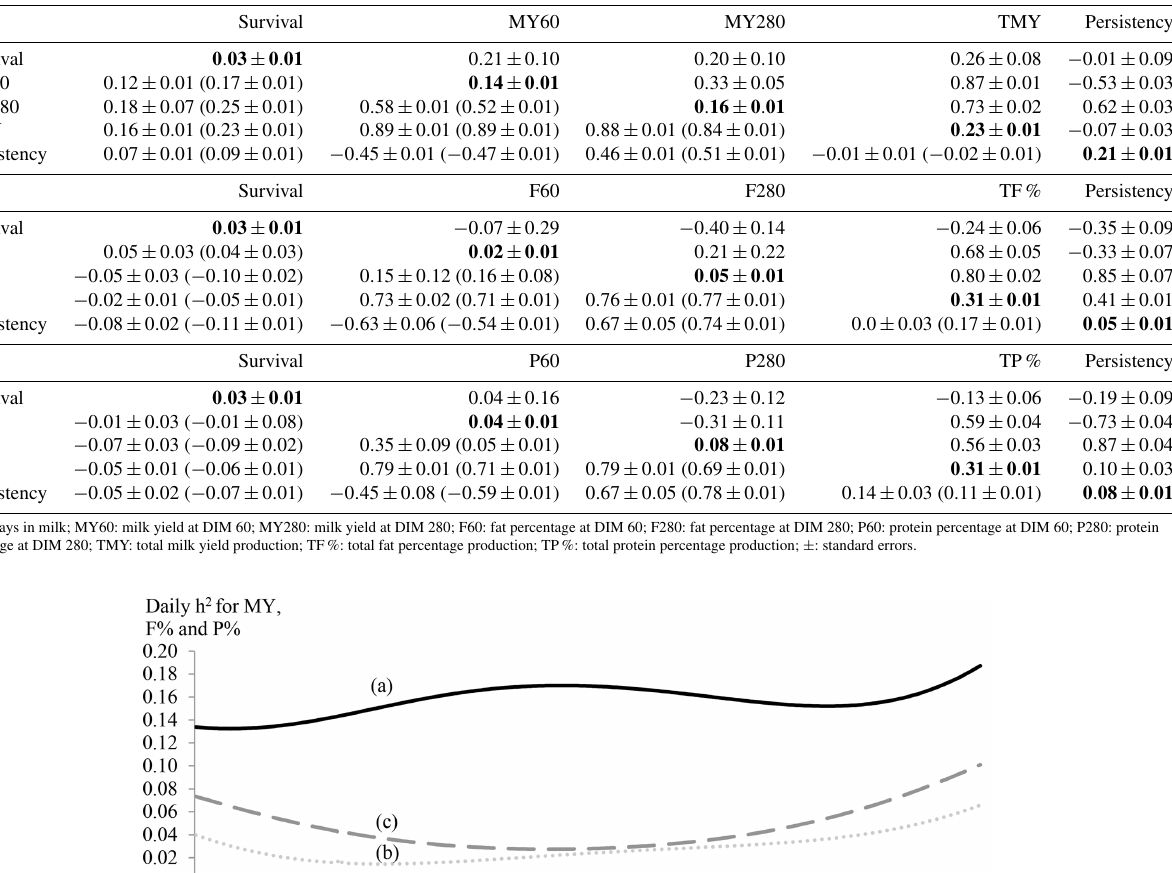
Table 2. Heritability (in bold), additive genetics (above the diagonal), permanent environment correlation (below the diagonal), cow-specific correlation (in brackets) between first lactation survival and MY60, MY280, F60, F280, P60, P280, TMY, TF%, TP% and P as well as associated standard errors.